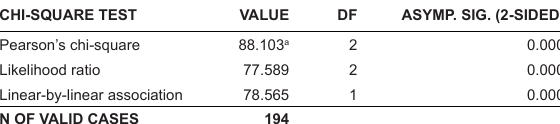
TABLE 2 Chi-square test results for the existence of an HIV/AIDS policy